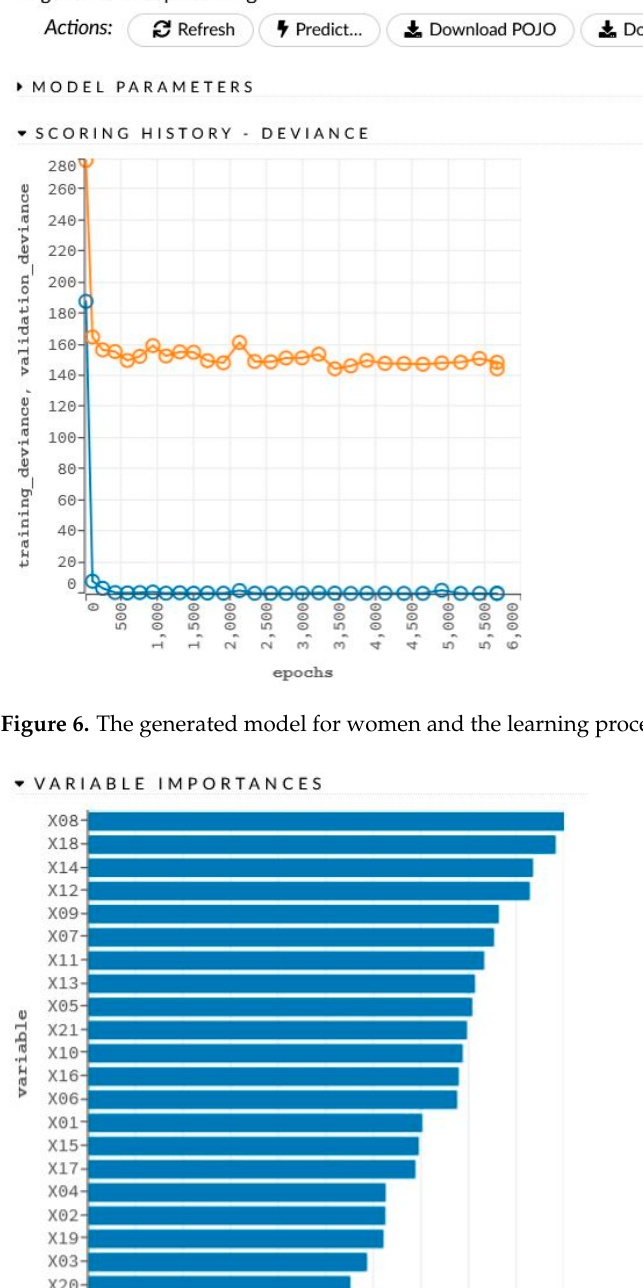
Table 7. Parameters of the generated models—prediction of age assessment. Women and Men Learning Set